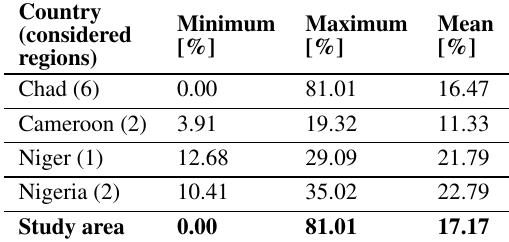
Table 2. Country statistics of calculated RAI results.